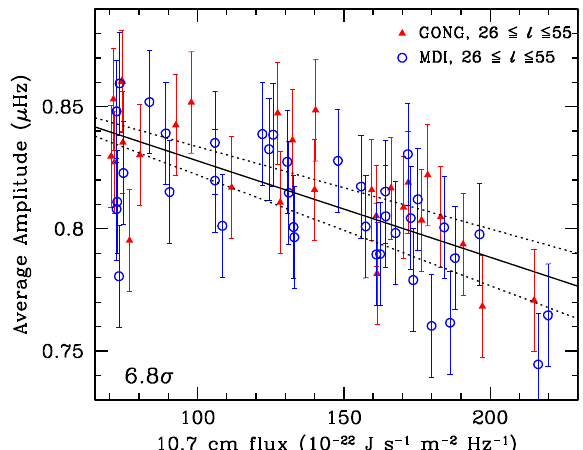
Fig. 30 The average amplitude of the oscillatory signal in the 4th differences of different MDI and GONG data sets plotted as a function of the 10.7-cm flux. The average was calculated in the frequency range 2–3.5mHz. The results were obtained for the degree range 26 ≤ (cid:2) ≤ 55. The black continuous line is a least-squares fit to all the data points. The dotted lines show the 1 σ uncertainty because of errors in the fitted parameters. The data used to plot the figure are from Basu and Mandel